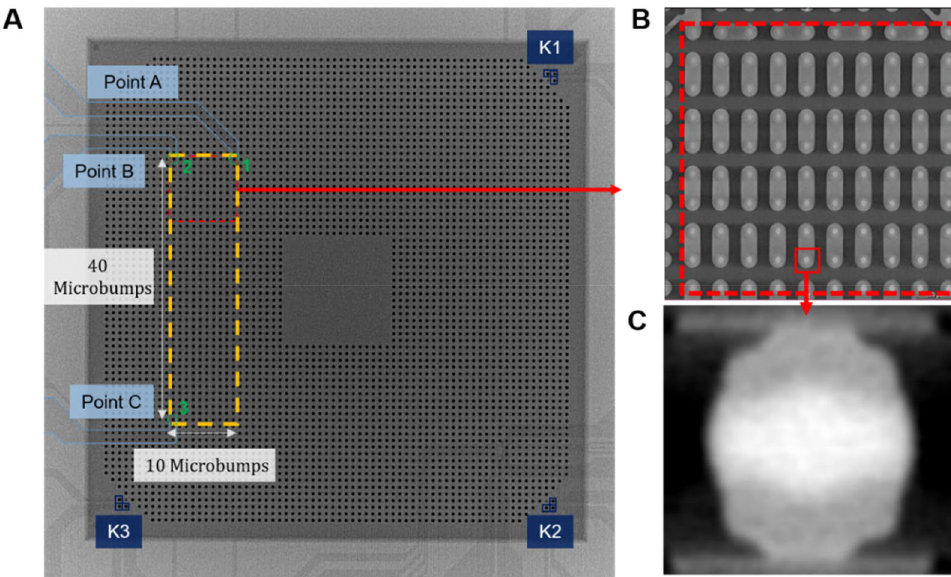
Figure 1. ( A ) The overall circuit diagram of a test sample by using SAT. Where the rectangular area marked by yellow dashed lines is ROI. ( B ) Zoom-in image of one-fourth of ROI containing 100 microbumps. ( C ) CT image of the cross-section of a